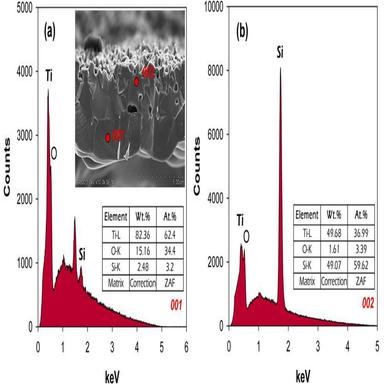
EDS of porous membrane prepared by fine powders with sintered pressure of 30 kPa at 1000 ℃.